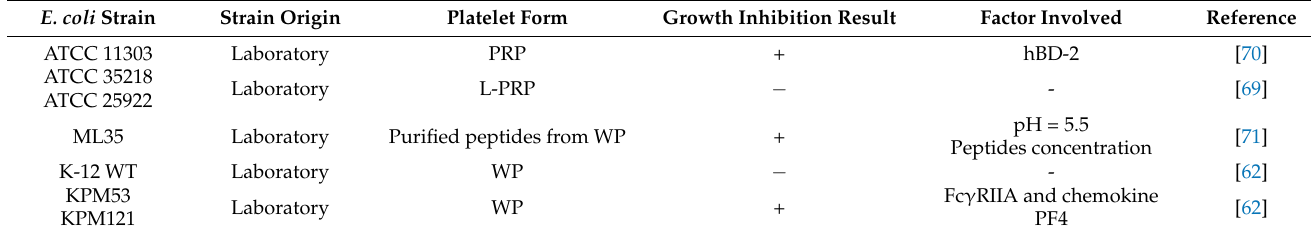
Table 2. Summary of platelet inhibitory effect on E. coli